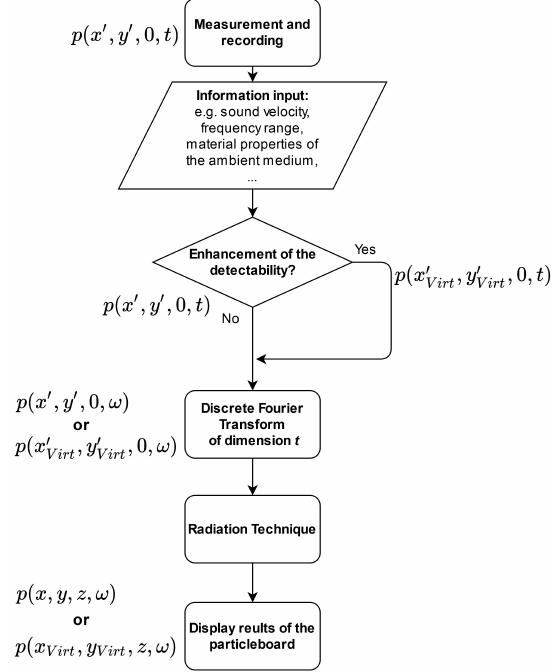
Figure 2. Flow chart for the practical realization of the spec-radiation and re-radiation